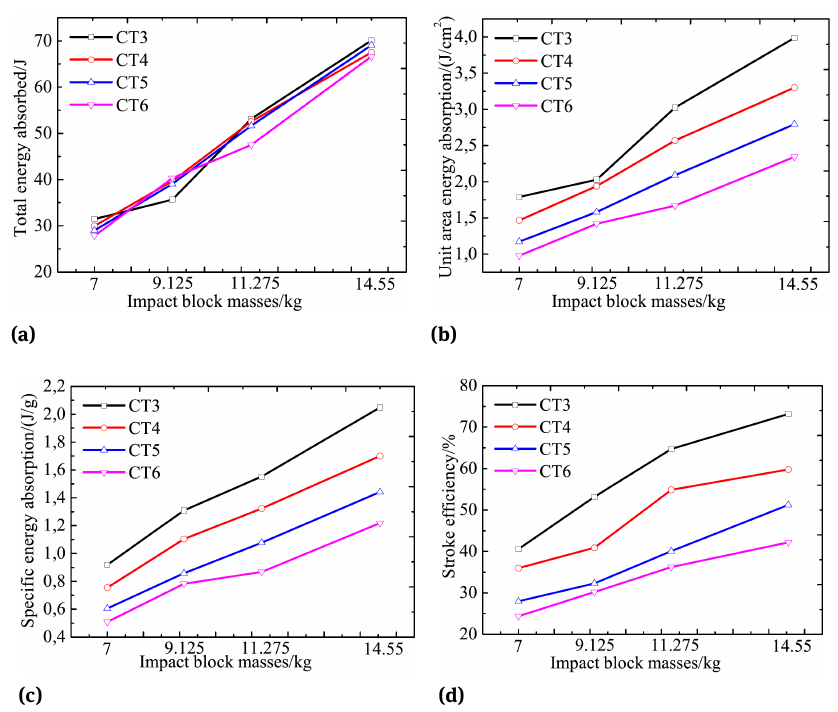
Figure 13: Cushioning energy absorption of X-direction paper corrugation tubes at different impact block masses: (a) total energy absorbed,